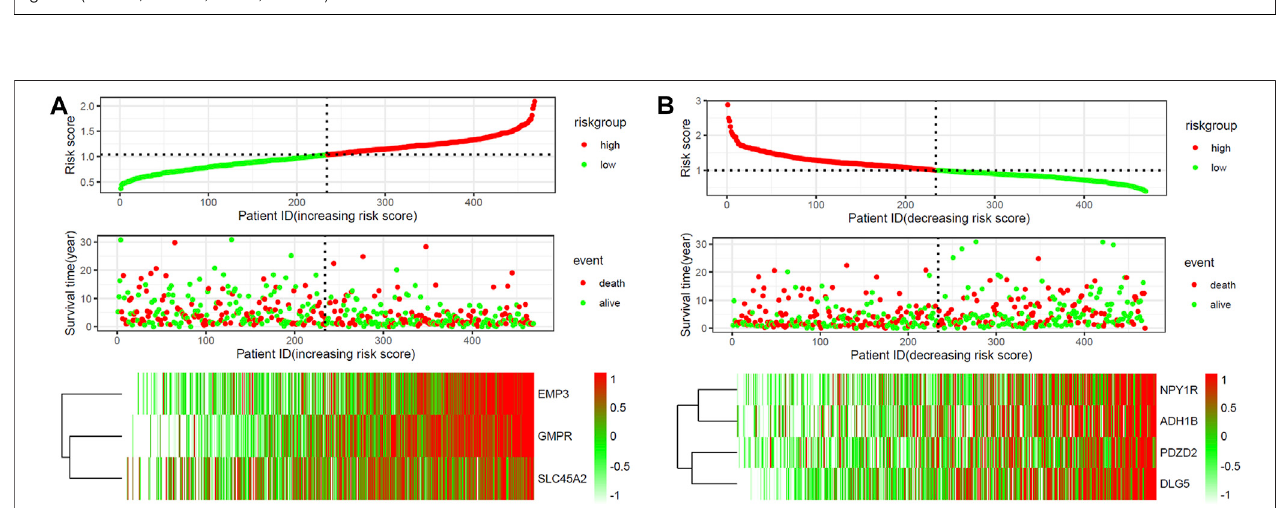
FIGURE9| TheriskscoresforallpatientsinTCGAcohortareplottedandmarkedaslowrisk(blue)orhighrisk(red),asdividedbythethreshold(verticalblackline). Expression pro fi les of the DEGs of patients in TCGA cohort, with red indicating higher expression and light blue indicating lower expression. (A) three screened up- regulated genes (GMPR, EMP3, SLC45A2). (B) four down-regulated genes (PDZD2, NPY1R, DLG5, ADH1B).